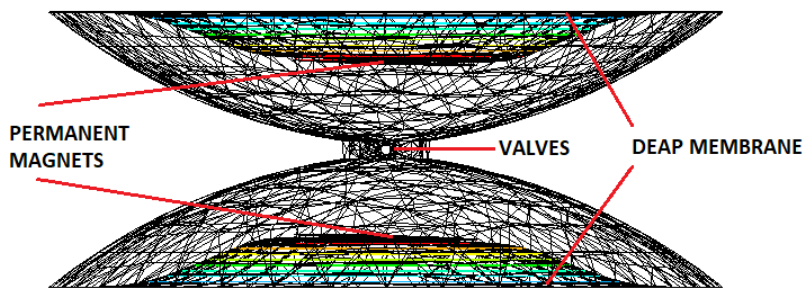
Figure 9. A pump concept built using a DEAP membrane and permanent magnets.